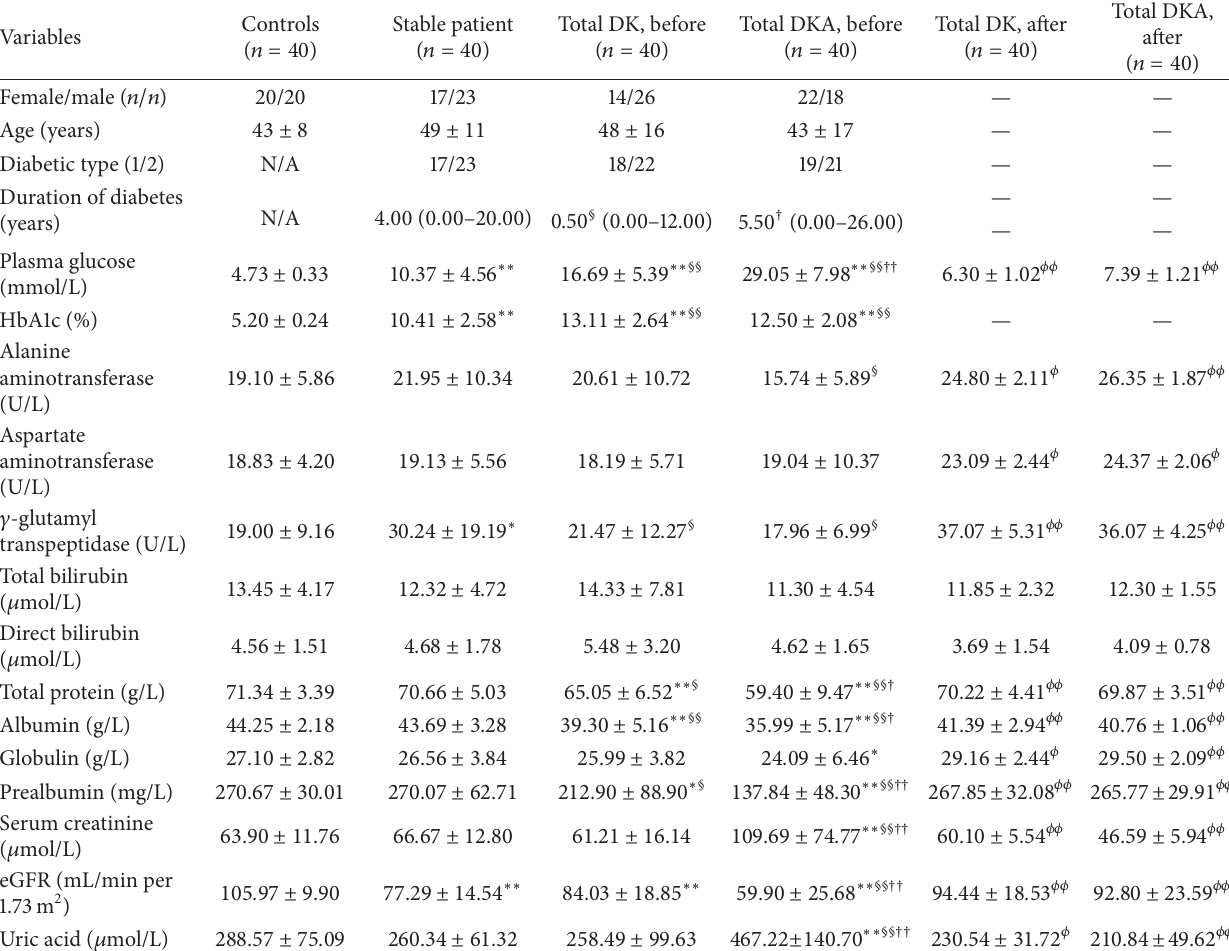
Table 1: Clinical and biochemical characteristics of the study participants before and after